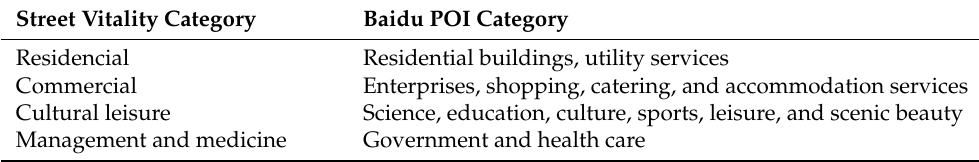
Table 6. Street functions based on Baidu